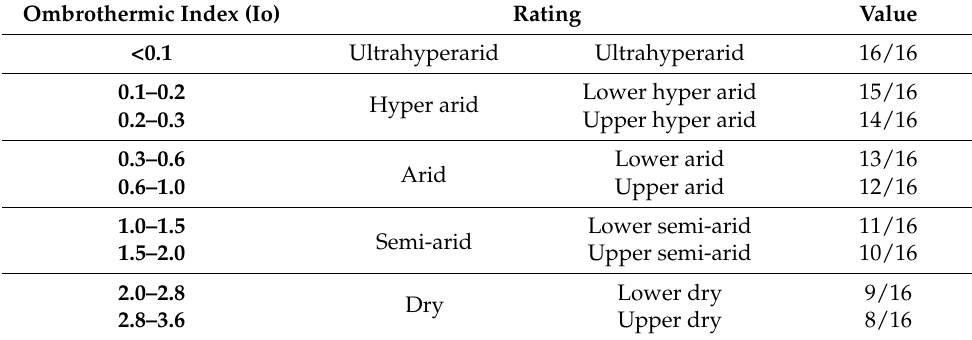
Table A10. Ombrothermic Index assigned values